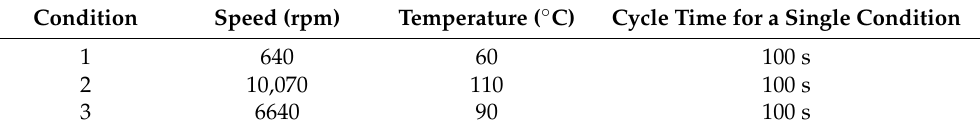
Table 5. Typical working condition points for fatigue aging and coupling failure modes.